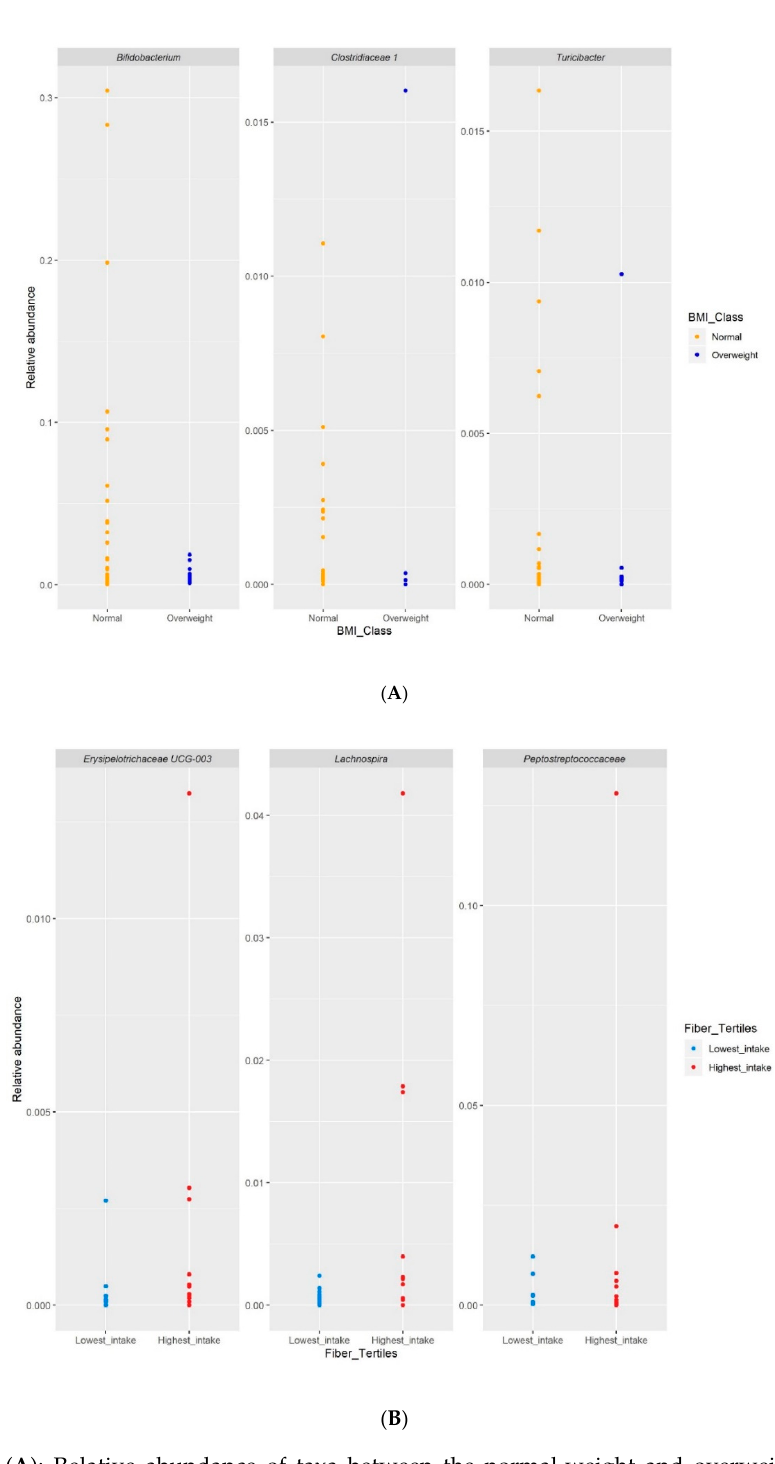
Figure 6. ( A ): Relative abundance of taxa between the normal-weight and overweight groups. ( B ): Differential relative abundance in genera by fiber intake tertile.